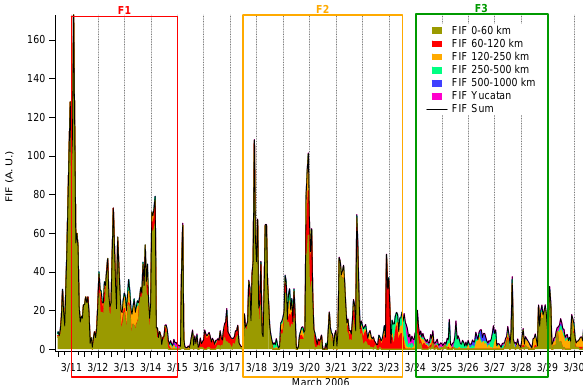
Fig. 4. Time series of the FIF 14 − 24 broken down according to the distance from T0 at which the fire emissions took place. Fire impact periods are also